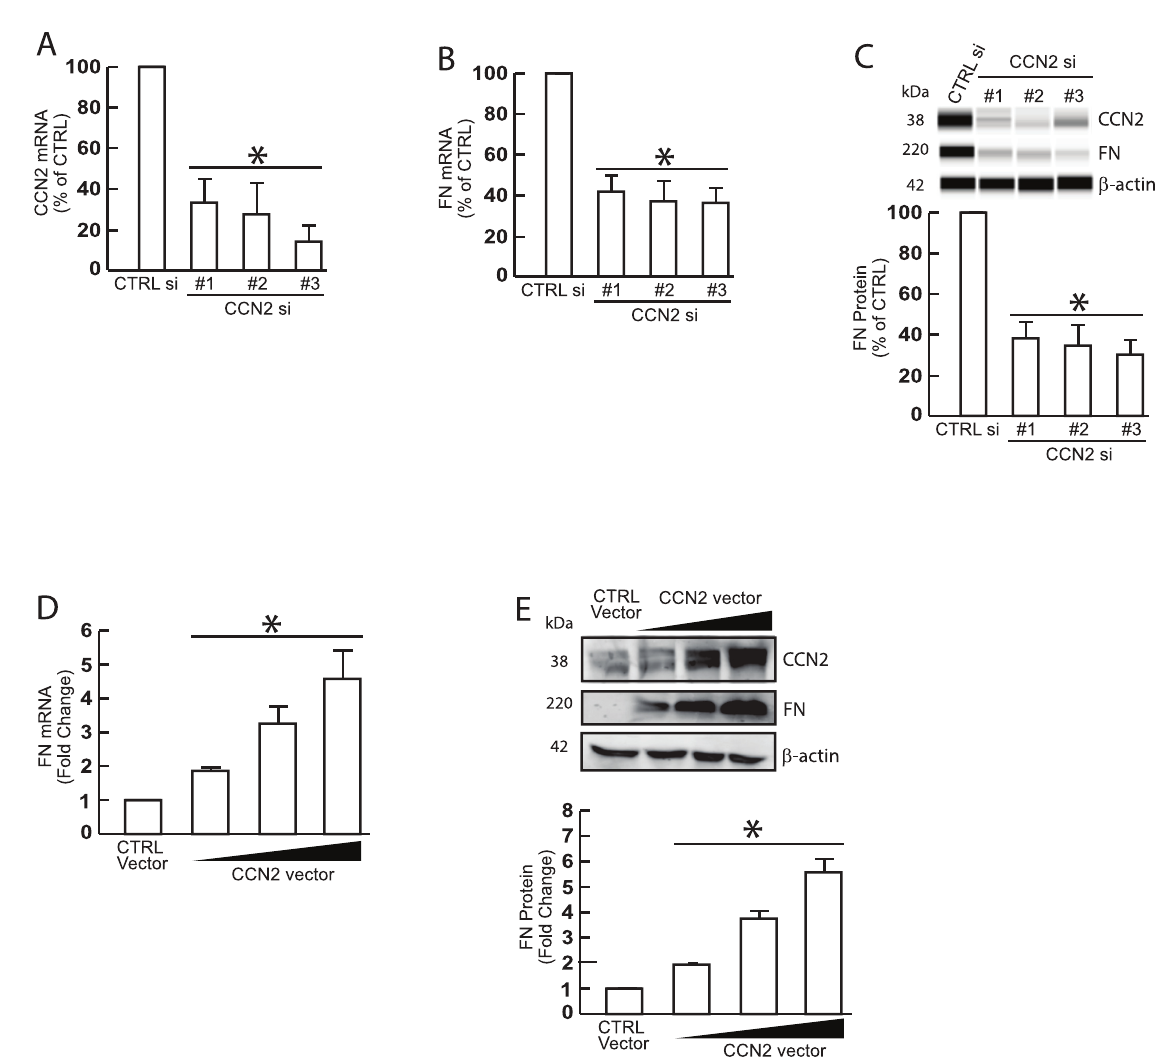
Fig 1. FN expression is regulated by CCN2 in primary dermal fibroblasts. Primary dermalfibroblasts(1 × 10 6 ) were transfected with non-specificcontrol siRNA or CCN2 siRNAs (20nM) (A, B, C), or control vector (pCDNA3.1, 2 μ g) or increasing amounts of CCN2 vector (0.5, 1, and 2 μ g) (D, E). Total RNA and wholecell extract were prepared48 hours after transfection. (A) CCN2 mRNA levels. (B) FN mRNA levels. (C) CCN and FN Protein levels. (D) FN mRNA levels. (E) CCN and FN protein levels. mRNA levels were quantified by real-time RT-PCR. Protein levels were determined by ProteinSimple capillaryelectrophoresis immunoassay (C) and Western analysis(E). mRNA levels were normalized to mRNA for 36B4, a ribosomal protein used as an internalcontrol quantitation. Protein levels were normalized by β -actin (loadingcontrol). Insets show representative digital images (C) and Western blots (E). Data are expressedas mean ± SEM, N = 3–5, * p <